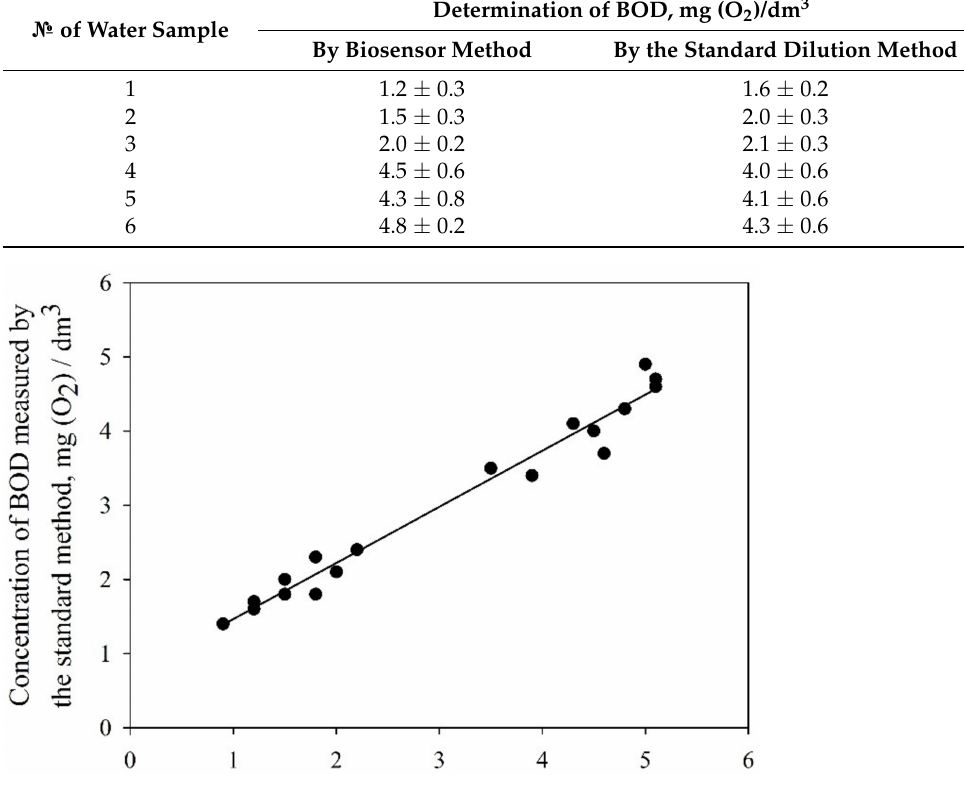
Figure 12. Graphical correlation of data produced by the biosensors and the standard